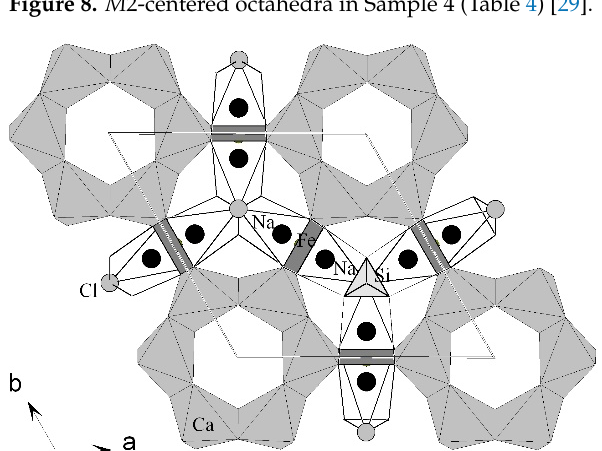
Minerals 2020 , 3, x Figure 8. M 2-centered octahedra in Sample 4 (Table 4) [29]. Figure 8. M 2-centered octahedra in Sample 4 (Table 4) [29].